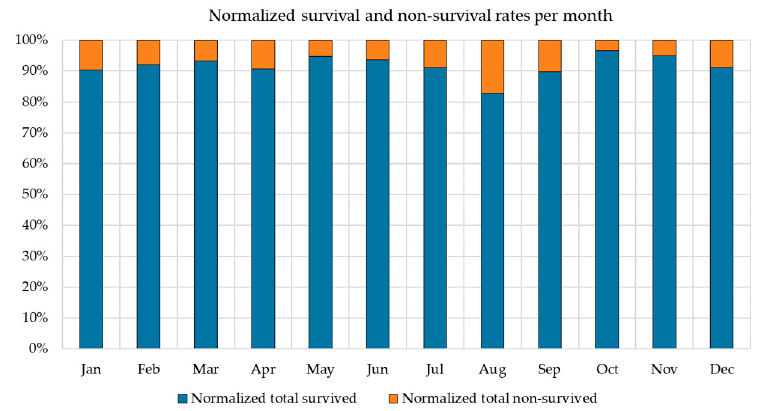
Figure A2. Survival distribution over the first year. In Figure A3, information about survival for two TAVI centers for a total amount of 2183 patients is shown.